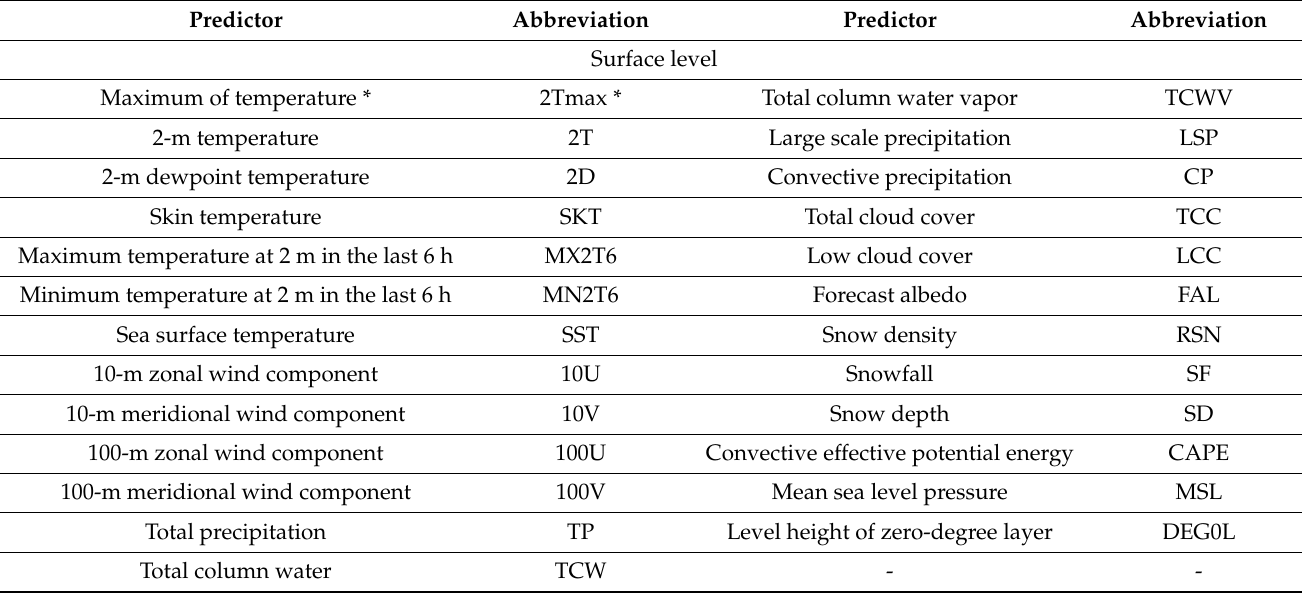
Table 1. The primary predictors taken from the ECMWF-IFS model and their abbreviations. Predictor